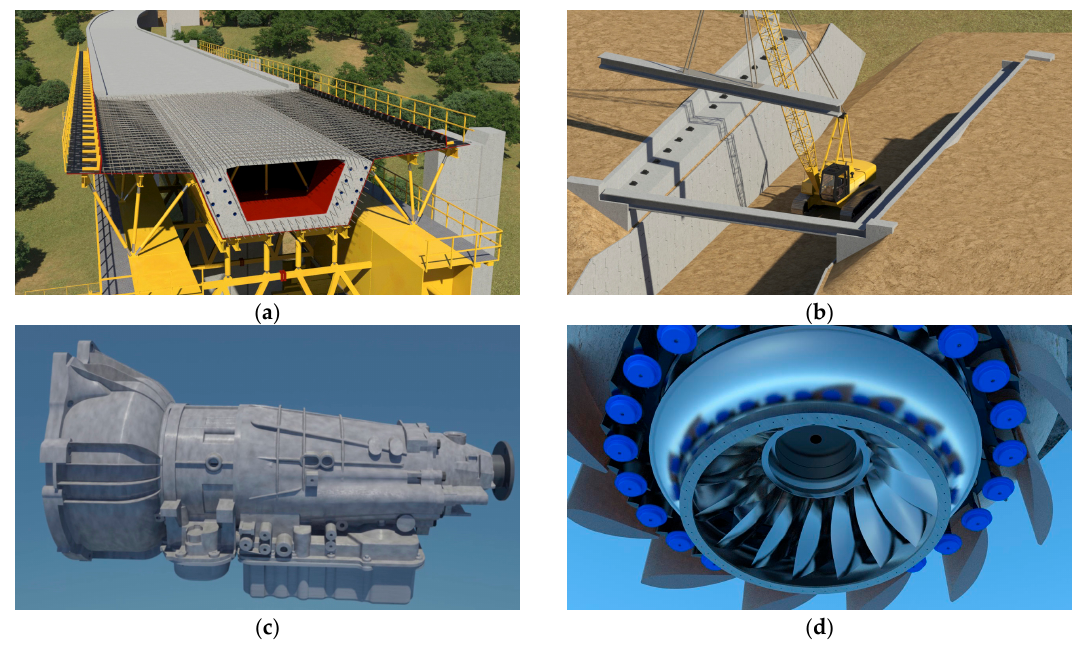
Figure 6. VR applications related to engineering: ( a ) bridge construction; ( b ) crane; ( c ) gearbox; ( d ) turbine.